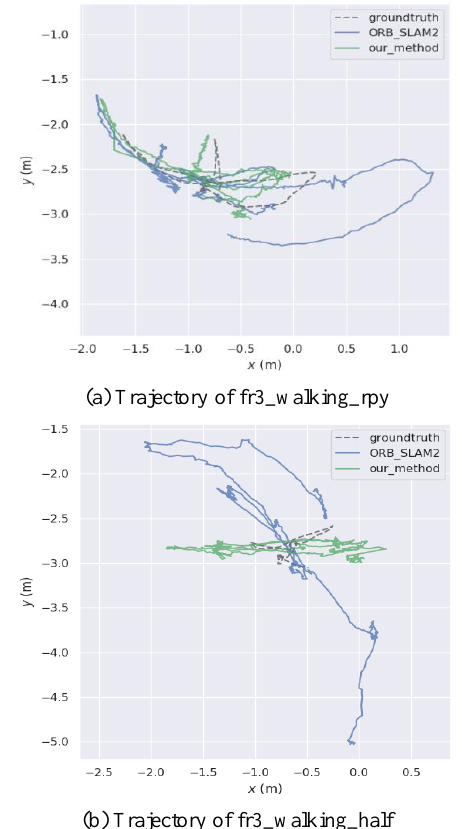
Figure 9. Trajectory predicted by ORB_SLAM2 and our system.